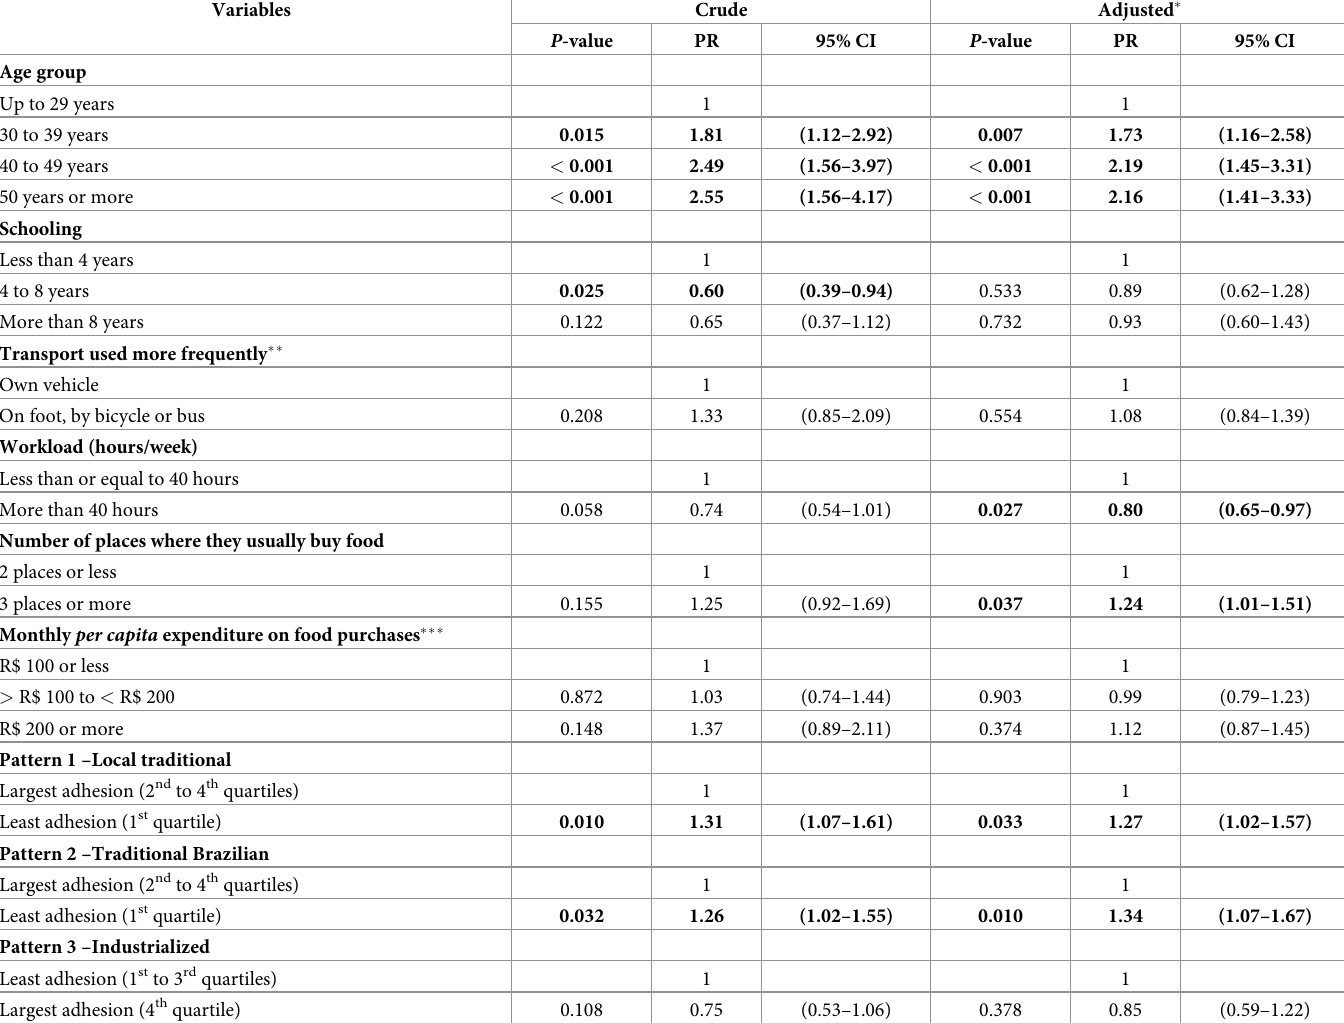
Table 8. Factors associated with abdominal obesity among women in a rural Brazilian